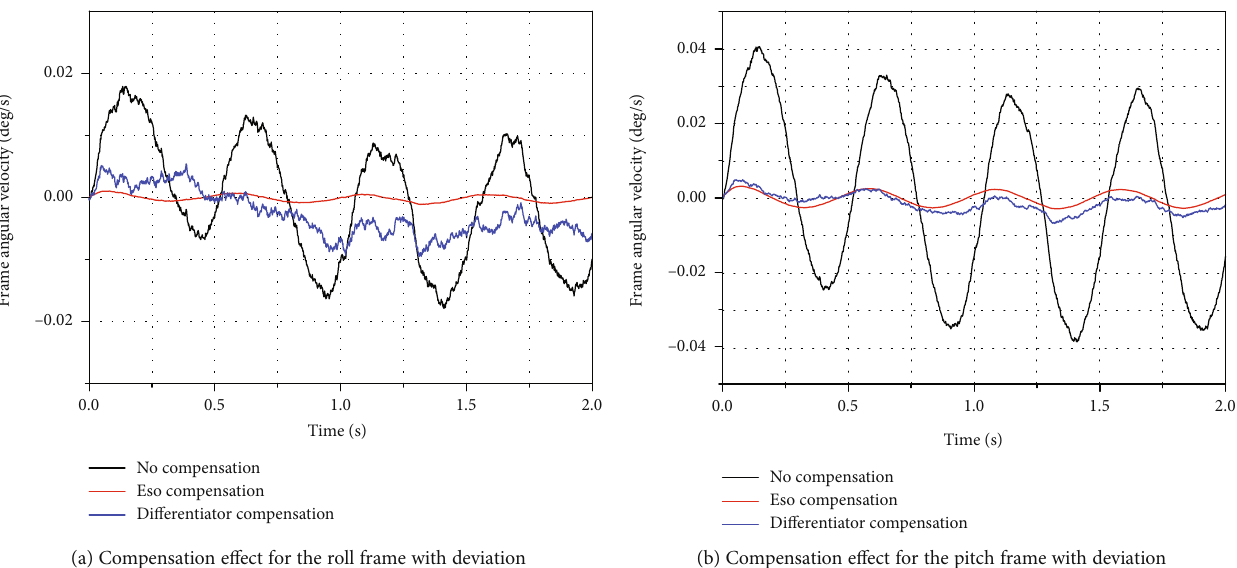
Figure 13: Angular velocity of the frame under interference torque with k